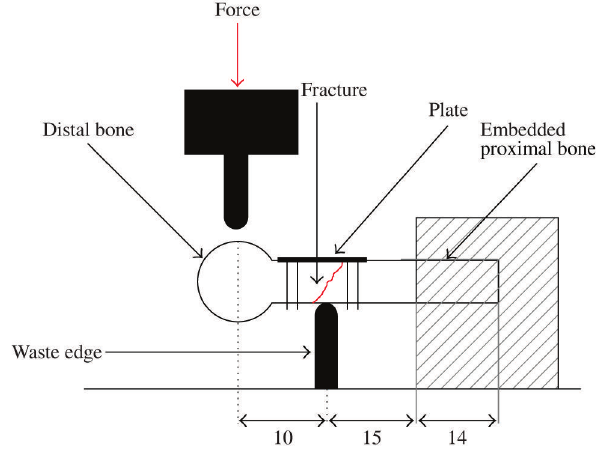
FIGURE 1: Test set up: embedded specimens were placed on a waste edge in a certain position (distance: fixation device-waste edge: 15 mm). Load application was apical distal (distance: waste edge-point of force transmission: 10 mm) with a constant speed of 100 mm/min until failure was noted.